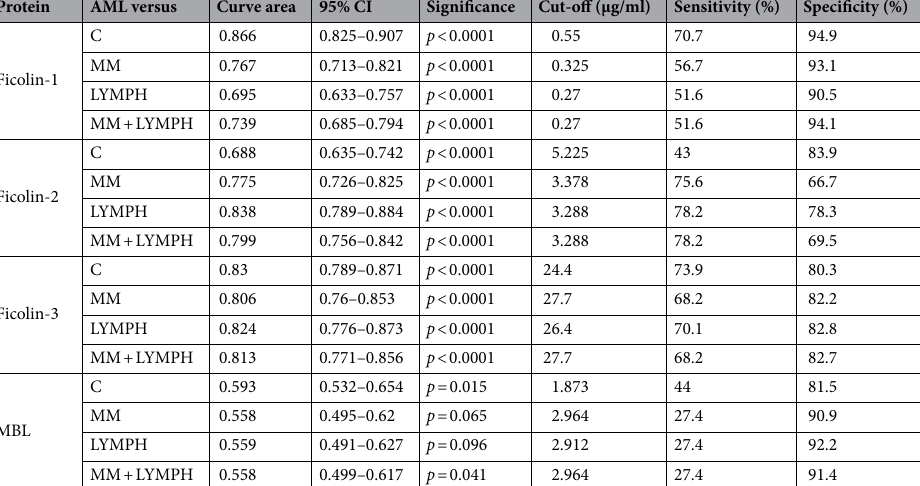
Table 4. Ficolins and mannose-binding lectin as potential disease markers (data from ROC analysis). AML acute myeloid leukaemia, C control (non-malignant), MM multiple myeloma, LYMPH lymphoma.